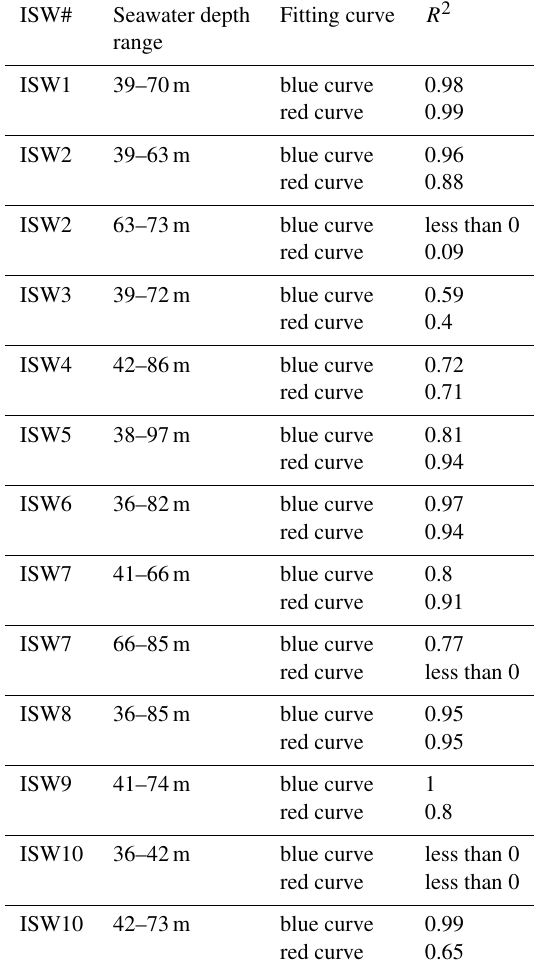
Table 6. Fitting effects of each curve in Fig. 11 on the observation points.